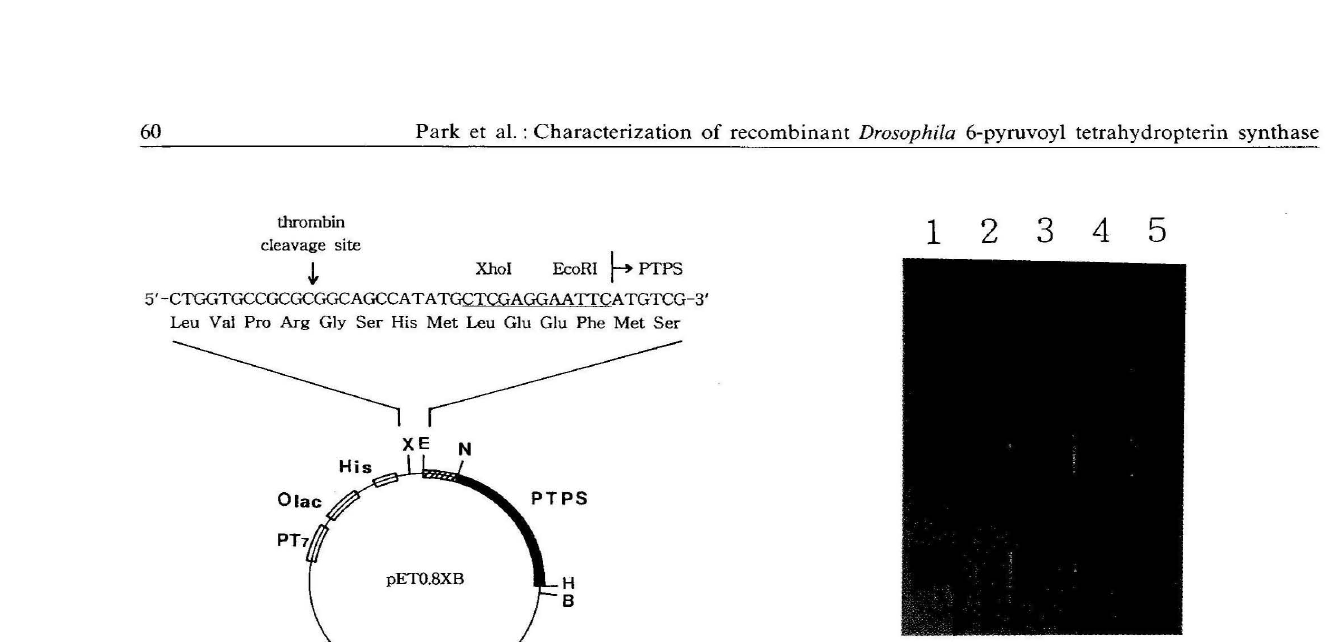
Figure 2. SOS PAGE of purification steps of recombinant PTP synthase. Lane 1, crude extract ; 2, the active fraction from metal chelation chromatography ; 3, the active fraction of Ultrogel AcA 44 ; 4, sample digested by thrombin ; 5, standard molecular markers, 66 kO, 45 kO, 31 kO, 21.6 kO, 14.5 kO. fusion peptide including 4 more amino acid resi dues originating from restriction sites for